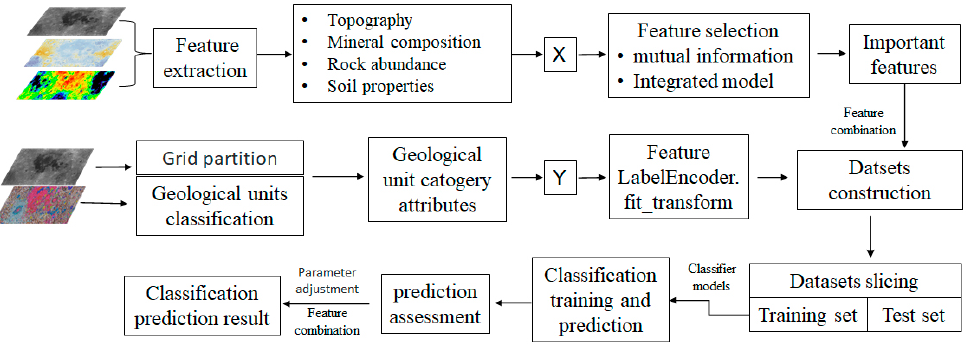
Figure 1. Flow chart of geological unit classification prediction based on machine learning in combination with multi-source data features.